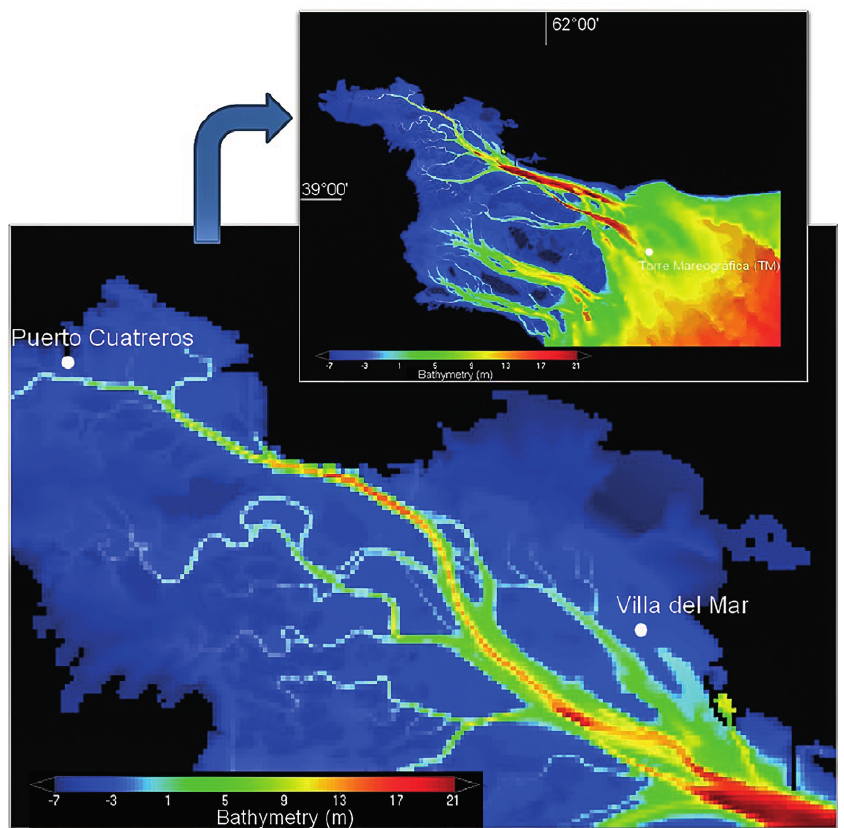
Fig. 3. – Bathymetry of the Bahía Blanca estuary, highlighting the sampling sites (modified from Pierini 2007).